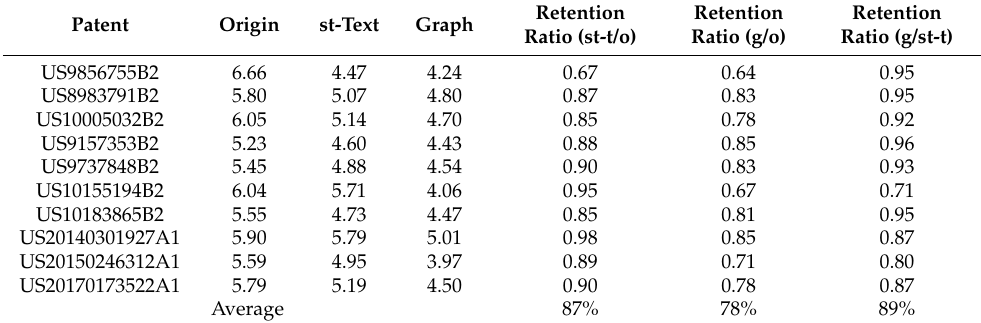
Table 2. Cluster 2 validation results.